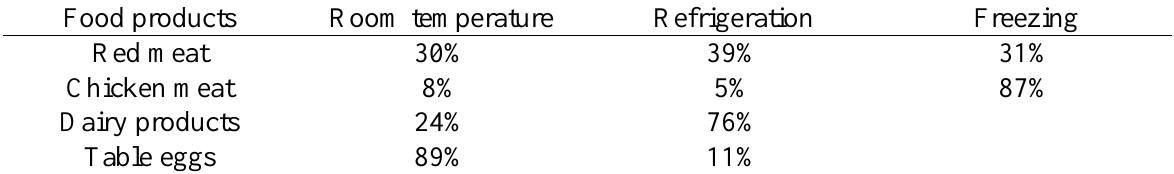
Table -1: Distribution of cattle by chiefdoms and towns in Koinadugu District, Sierra Leone: Food